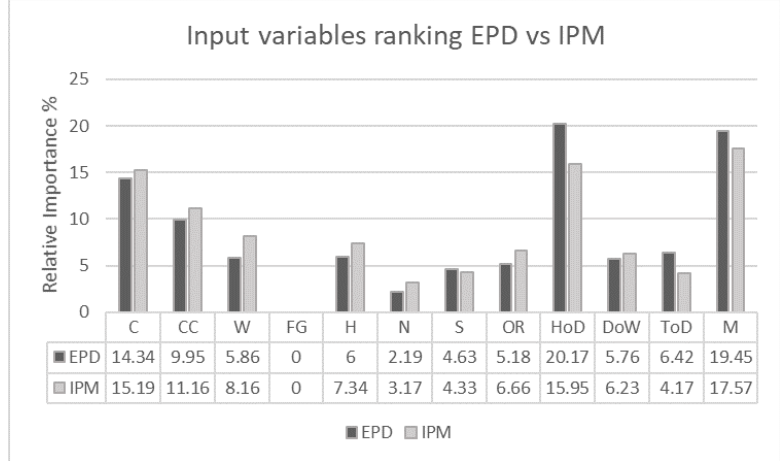
Figure 15. Relative importance in % to the joint response (demand and price of electricity) of fundamental and continuous variables using the VIT EPD and